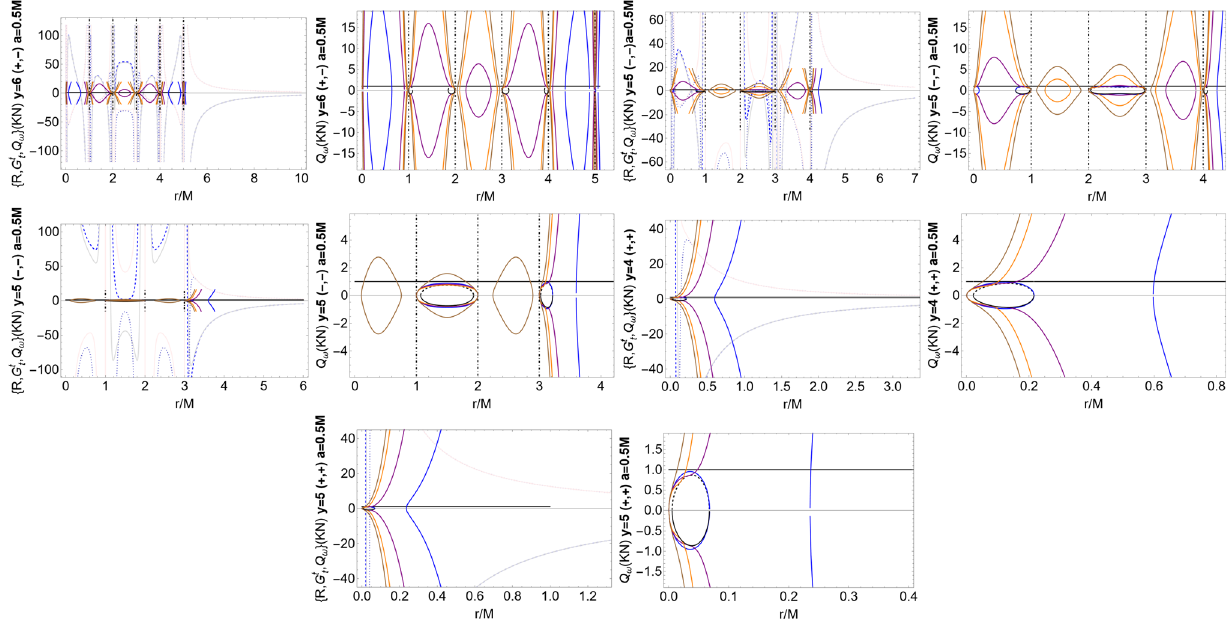
Fig. 23 Deformation of the Kerr–Newman reference metric in Boyer– Lindquist coordinates (metric signature ( − , + , + , + ) ) on the equa- torial plane ( θ = π/ 2) where M = 1. Metric bundles Q ω , Ricci curvature scalar R and Einstein tensor component G t t are shown for spin a = 0 . 5 and different deformation parameters { ( b , f ), y } , where { blue , purple , orange , bro w n } curvesreferto MB sfrequencies { ω =